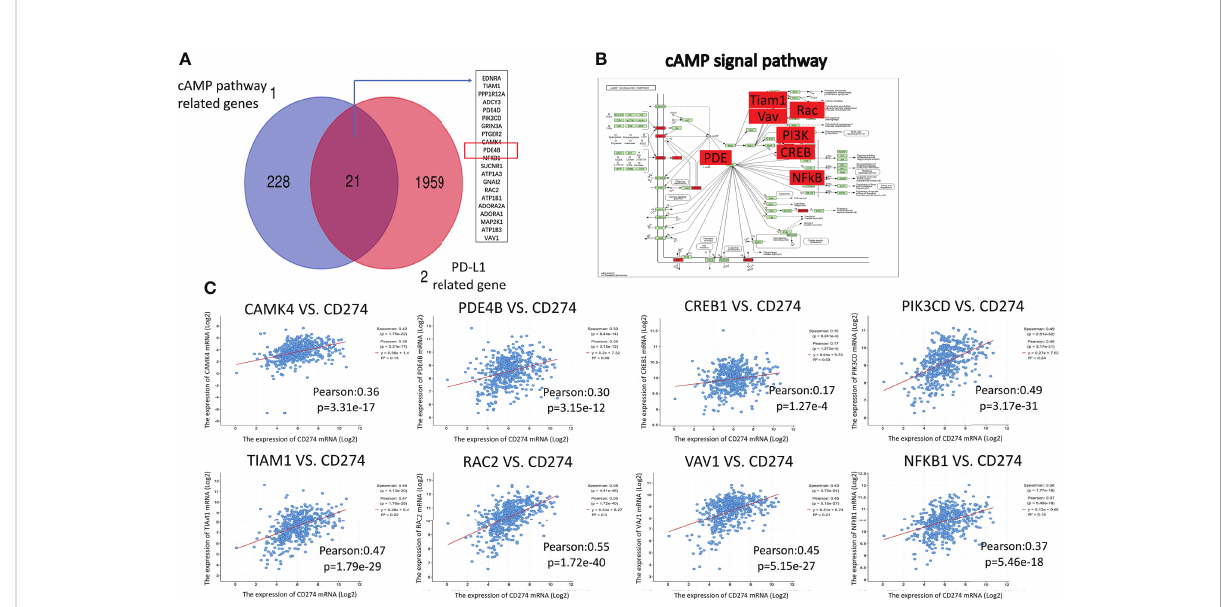
FIGURE 2 Correlation analysis between cAMP pathway genes and PD-L1. (A) : A Venn diagram was mapped for the cAMP pathway and PD-L1-related gene groups. There were 21 overlapping genes. (B) : The overlapping genes were placed in the KEGG cAMP pathway diagram (red-labeled genes). (C) : TCGA online visual database CBioPortal was used to analyze the correlation between cAMP pathway genes and PD-L1, which showed a close